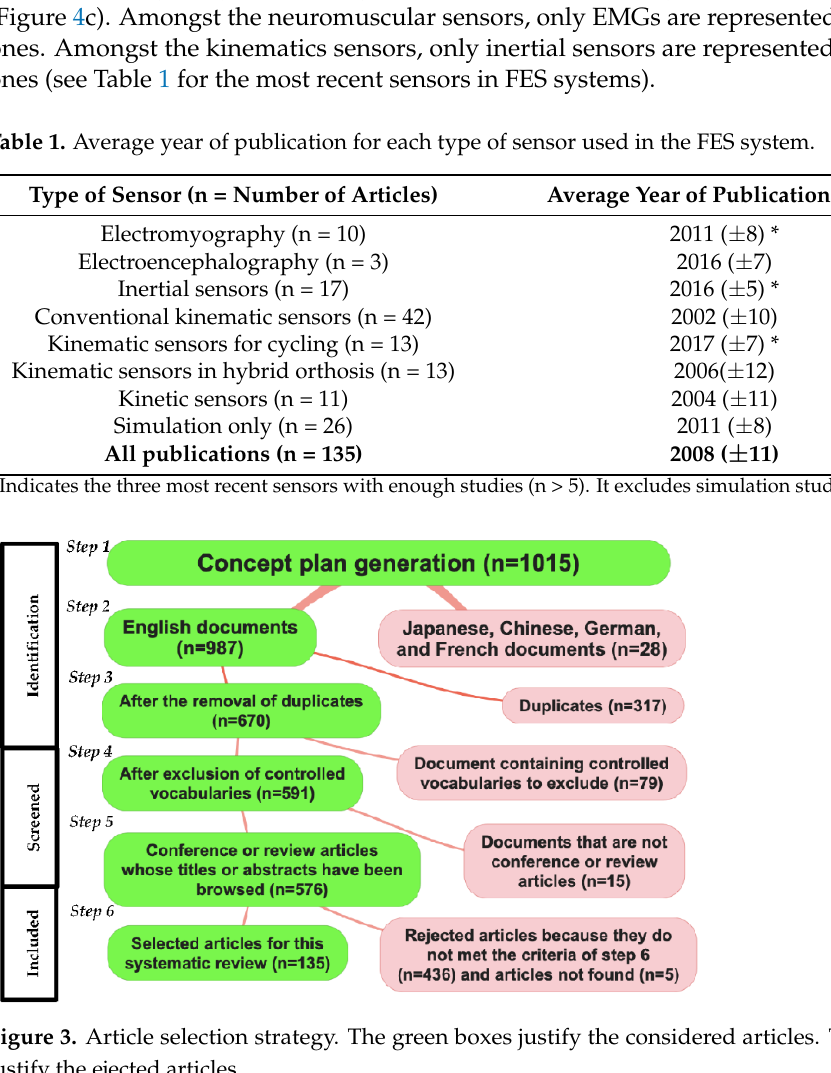
Figure 4. Overall overview for each category of sensor: ( a ) Electromyogramphy; ( b ) Inertial sensors; ( c ) Kinetic sensors. 1st Column: Modeling method; 2nd Column: Controlled variable; 3rd Column: Control Strategy. P: Proportional; I: Integral; D: Derivative [14,15,19 – 21,23,24,36 – 65].